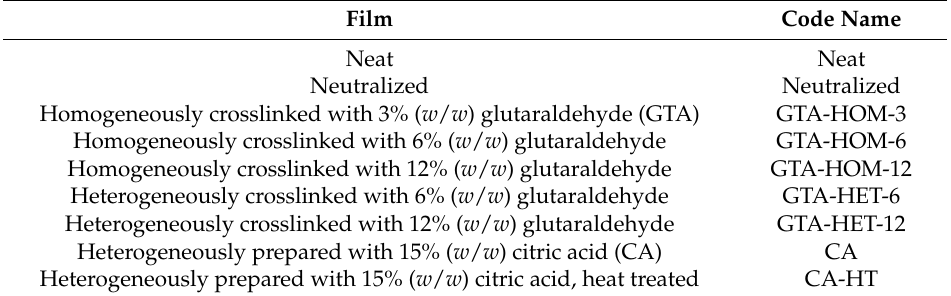
Table 2. Chitosan Film